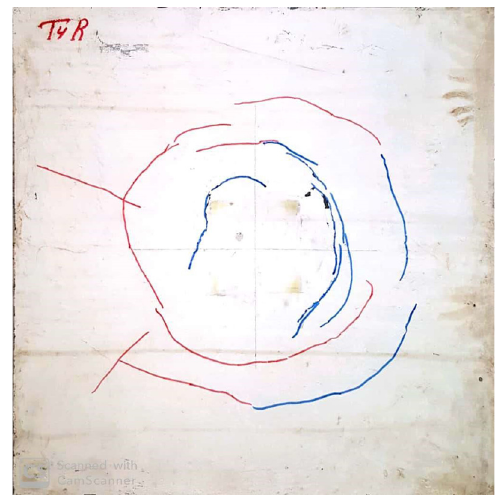
Figure 15: Crack pattern under impact - fl exural loads of the top face of the slab T4R.